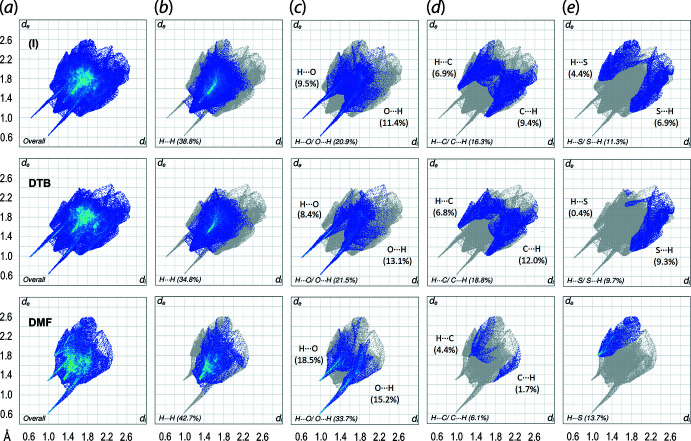
(a) The overall two-dimensional fingerprint plots for (I) (upper view), DTBA (middle) and DMF (lower) showing the corresponding overall fingerprint profiles as well as those delineated into (b) H⋯H, (c) H⋯O/ O⋯H, (d) H⋯C/ C⋯H and (e) H⋯S/ S⋯H contacts, with the percentage contributions being specified for each contact indicated therein.